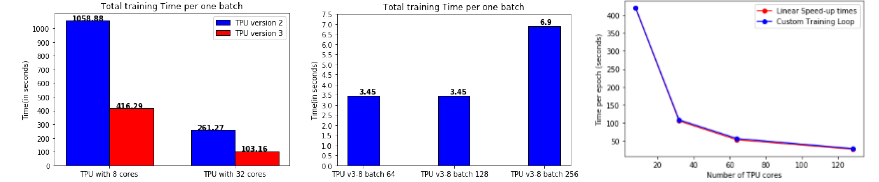
Figure 2. (left) Time per epoch (in seconds) on 8 cores v2 and v3 TPU, BS = 128. (center) Time per epoch (in seconds) on 8 cores v3 TPU for batch sizes BS = 64 , 128 , 256. (right) Measured training time per epoch (in seconds) compared to the theoretical linear speed-up. Figure 1. (left) Discriminator training times divided between processing, real data training and fake data training. (right) Generator training times. Times are quoted for one data batch.